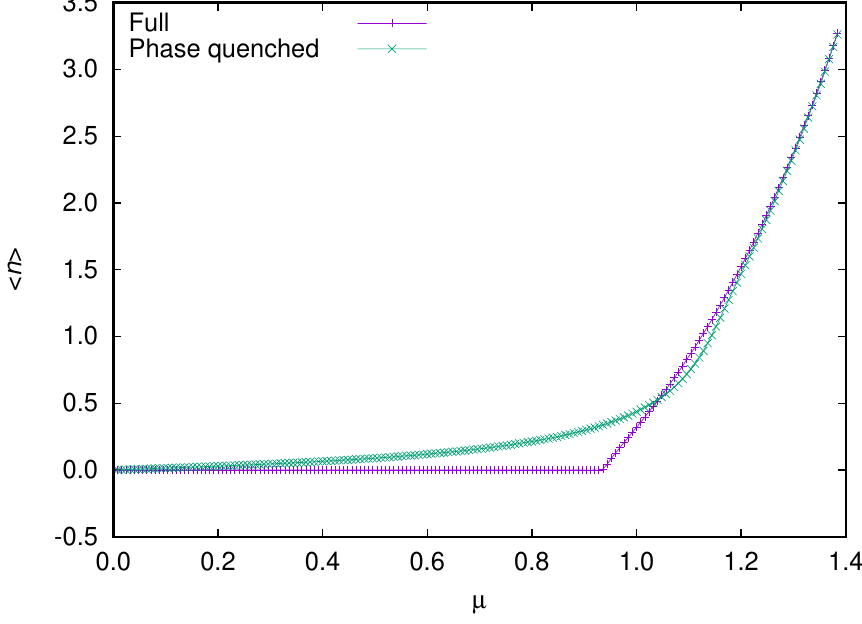
Figure 5 . Comparison of the number density between the full and the phase quenched theories at m 2 = 0 : 01, (cid:21) = 1, K = D = 64 on V = 1024 2 . The full theory clearly shows the Silver Blaze phenomenon unlike the phase quenched case.